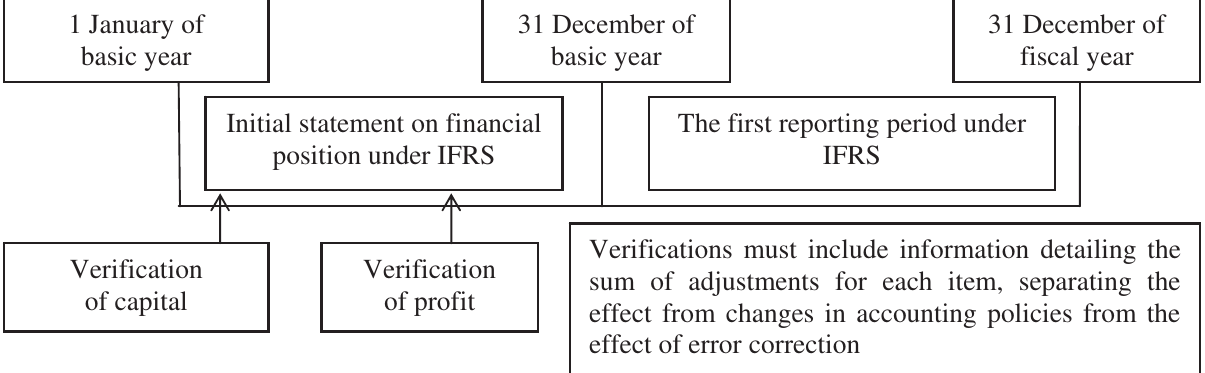
Fig. 3. Verifications according to the requirements of IFRS 1 (Golov,